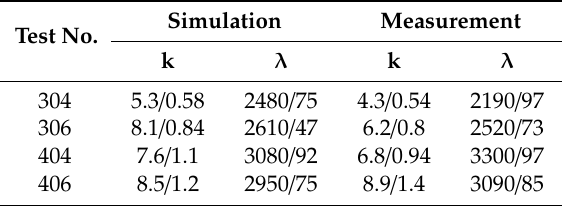
Table 8. Statistics for the shape and scale factors for tests 304 , 306 , 404, and 406 (estimated / Std. error). Simulation Measurement Test No. k λ